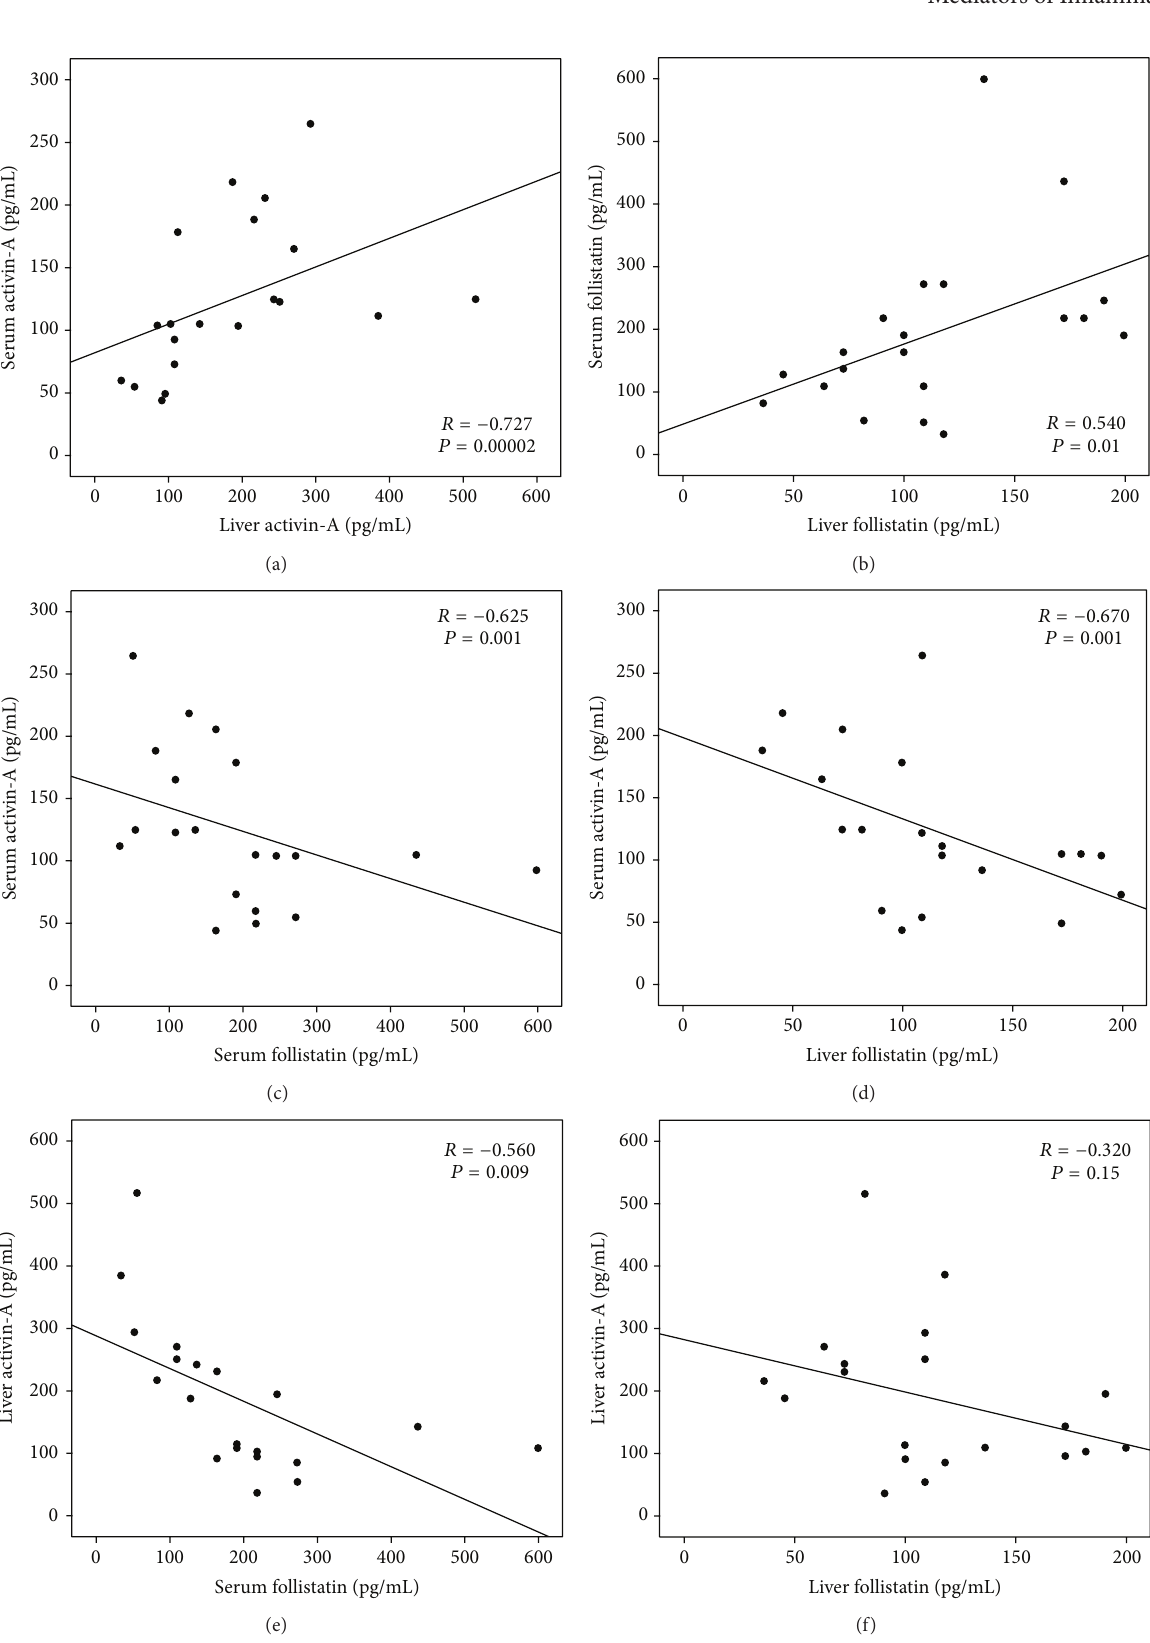
Figure 4: Correlation between (a) serum and liver activin-A, (b) serum and liver follistatin, (c) serum activin-A and serum follistatin, (d) serum activin-A and liver follistatin, (e) liver activin-A and serum follistatin, and (f) liver activin-A and follistatin by Pearson’s correlation